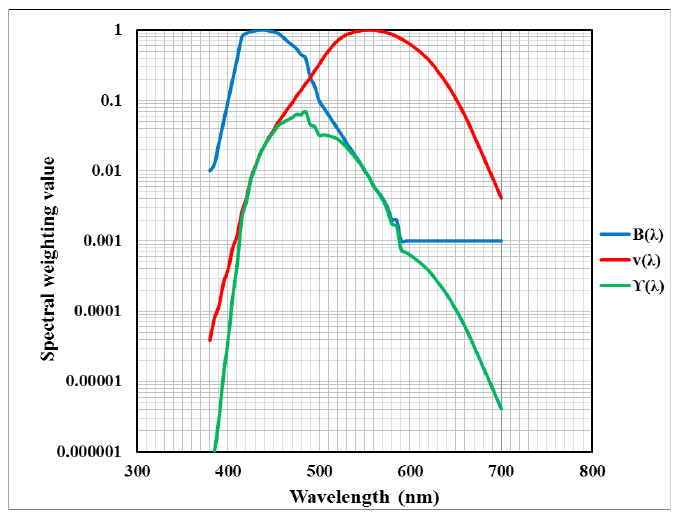
, Photopic function, V (λ)